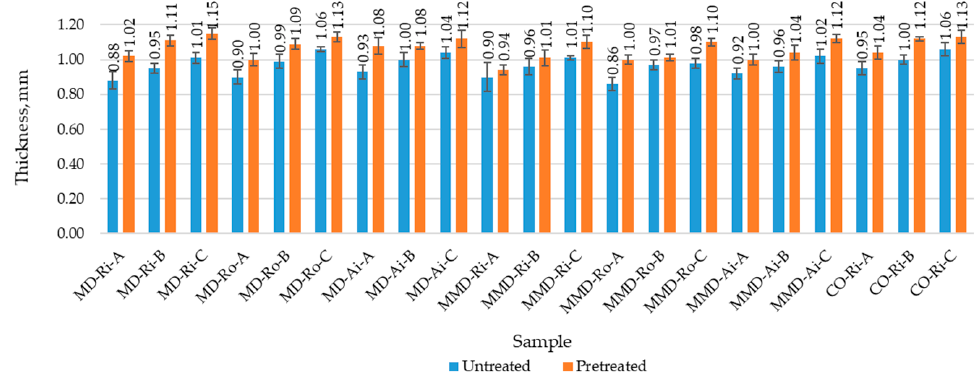
Figure 10. Thickness of the untreated and pretreated sock plain knit samples determined before and after five repeated washing and drying cycles of the socks (where MD—modal fibers, MMD—micro modal fibers, CO—cotton fibers; Ri—ring spun yarn, Ro—rotor spun yarn, Ai—air-jet spun yarn; A, B, C—sock group).